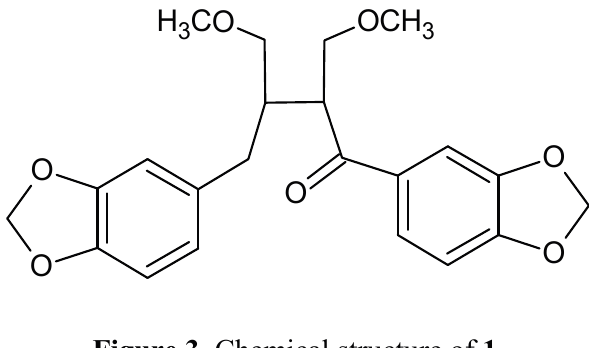
Figure 3. Chemical structure of 1